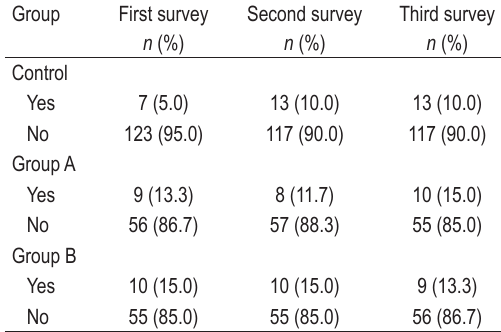
TABLE 8. Necessity of medical assistance after the